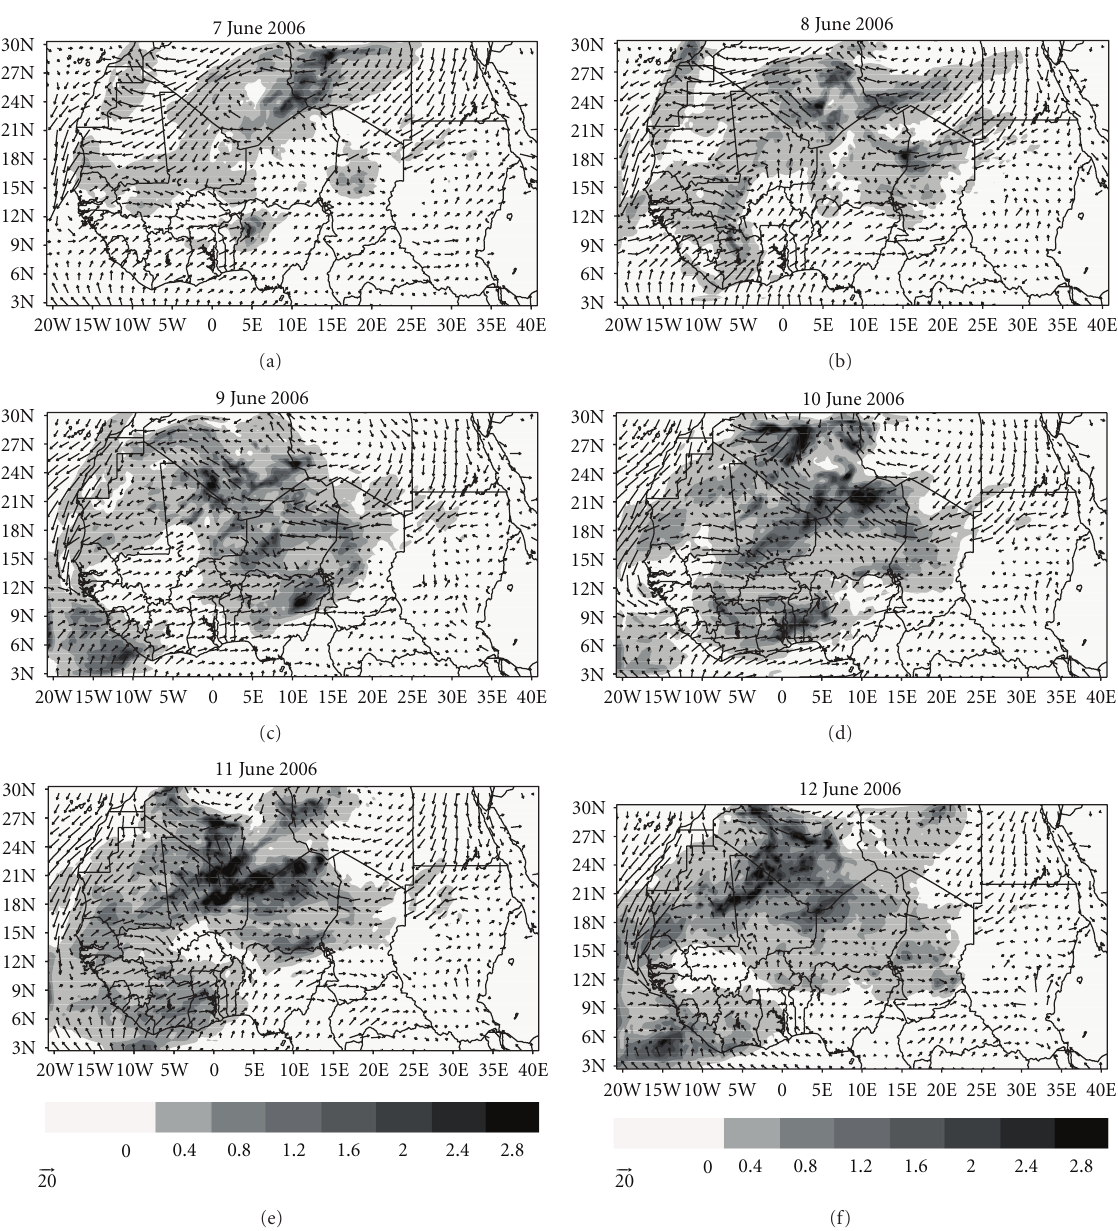
Figure 6: WRF-Chem EXP30-simulated AOT from the 7th to 12th of June, 2006 at 1200 UTC. Wind direction (vectors) at 925 mb is also